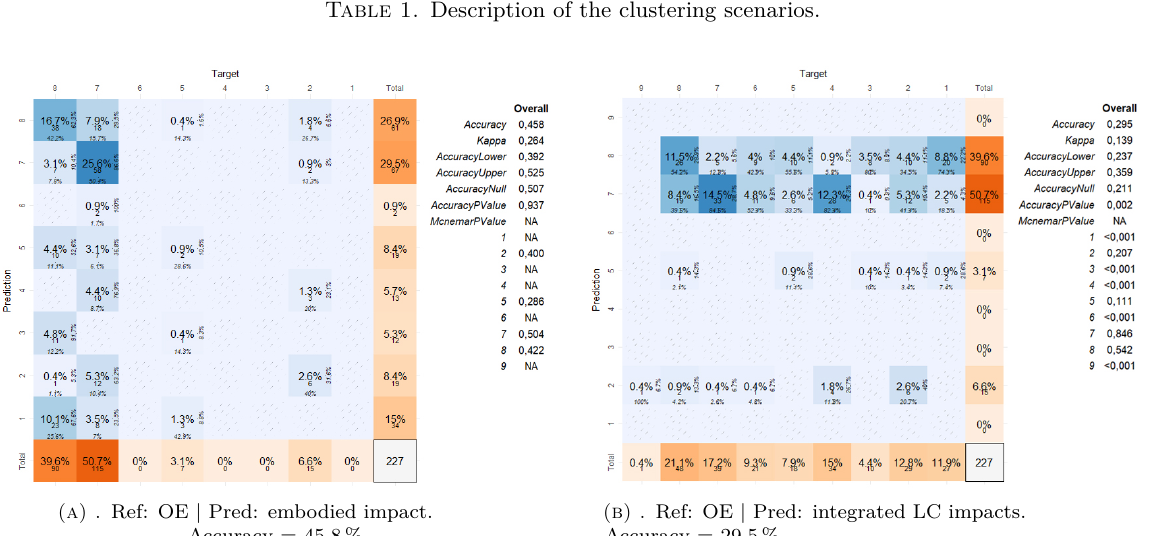
Figure 1. Confusion matrices relating operational energy (OE) parameters (reference) to predicted embodied (A) and to integrated life cycle impacts (UBiM) (B) and respective model accuracies.